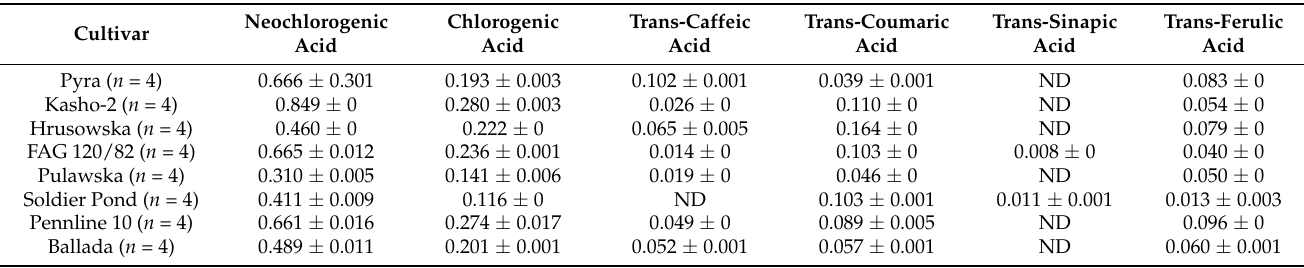
Table 1. Content of phenolic acids in leaves of investigated buckwheat cultivars (mg/g d.w., means ± standard deviations of four independent